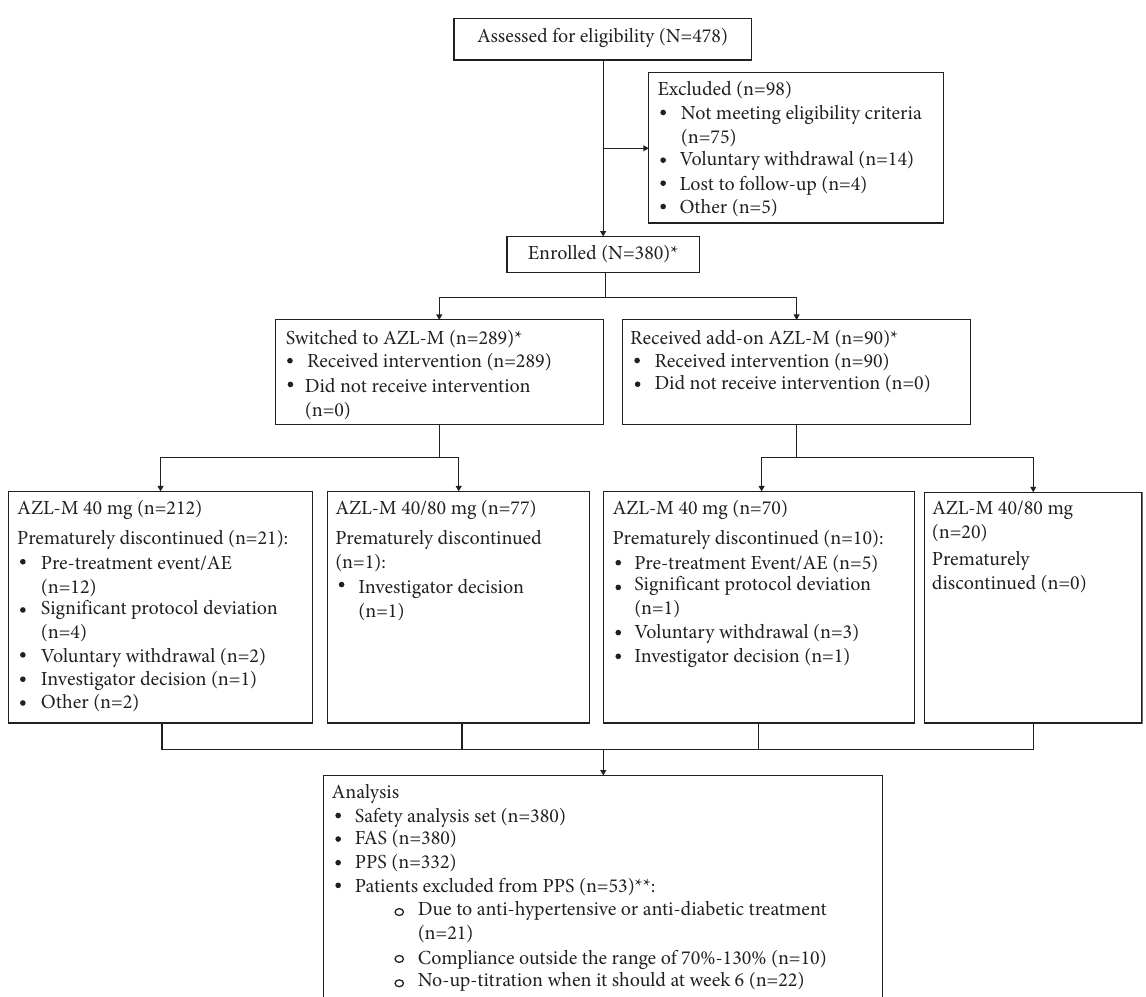
Figure 1: Flow diagram for patients in the study. AE, adverse event; AZL-M, azilsartan.168, medoxomil; FAS, full analysis set; and PPS, per protocol set. ∗ One patient from the “treatment-na¨ıve” group was considered only in the overall analysis. ∗∗ The same patient meeting multiple per protocol set exclusion criteria is counted under each